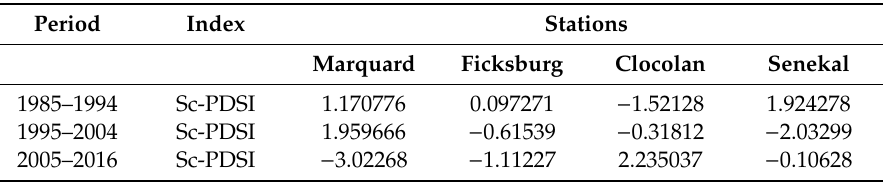
Table 11. The average Self calibrating Palmer Drought Severity index (Sc_PDSI)